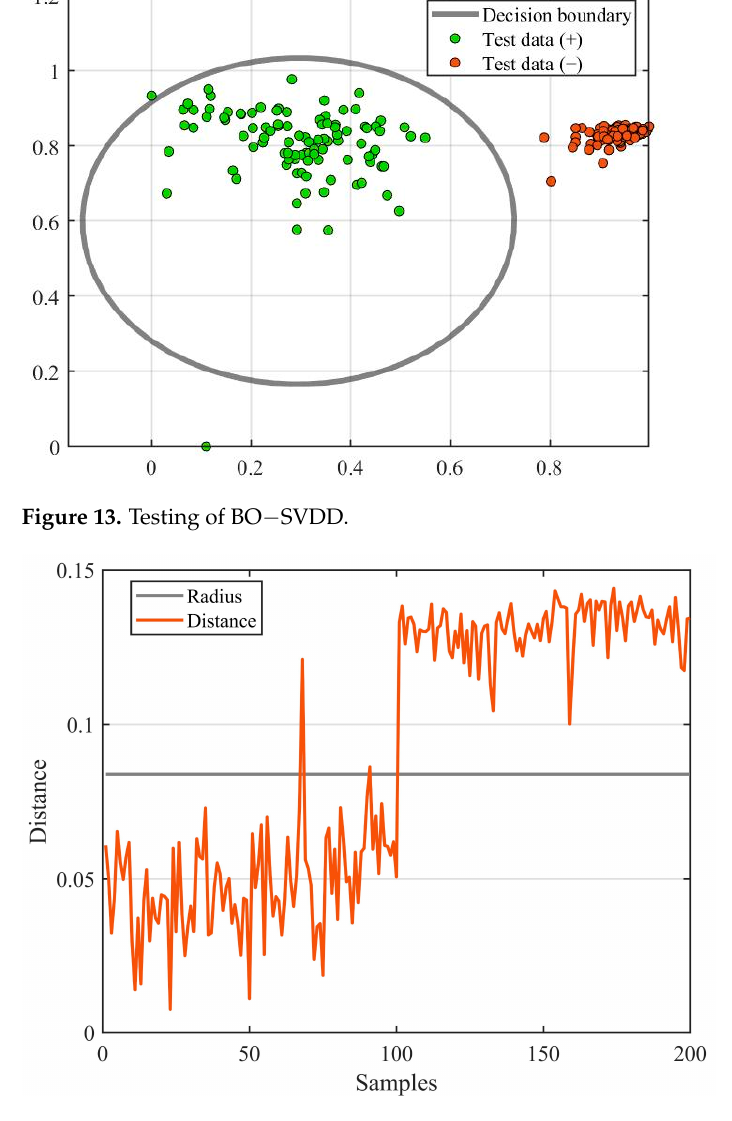
Figure 14. Identifying the results of damage of BO − SVDD. Table 3. Parameters and results of the